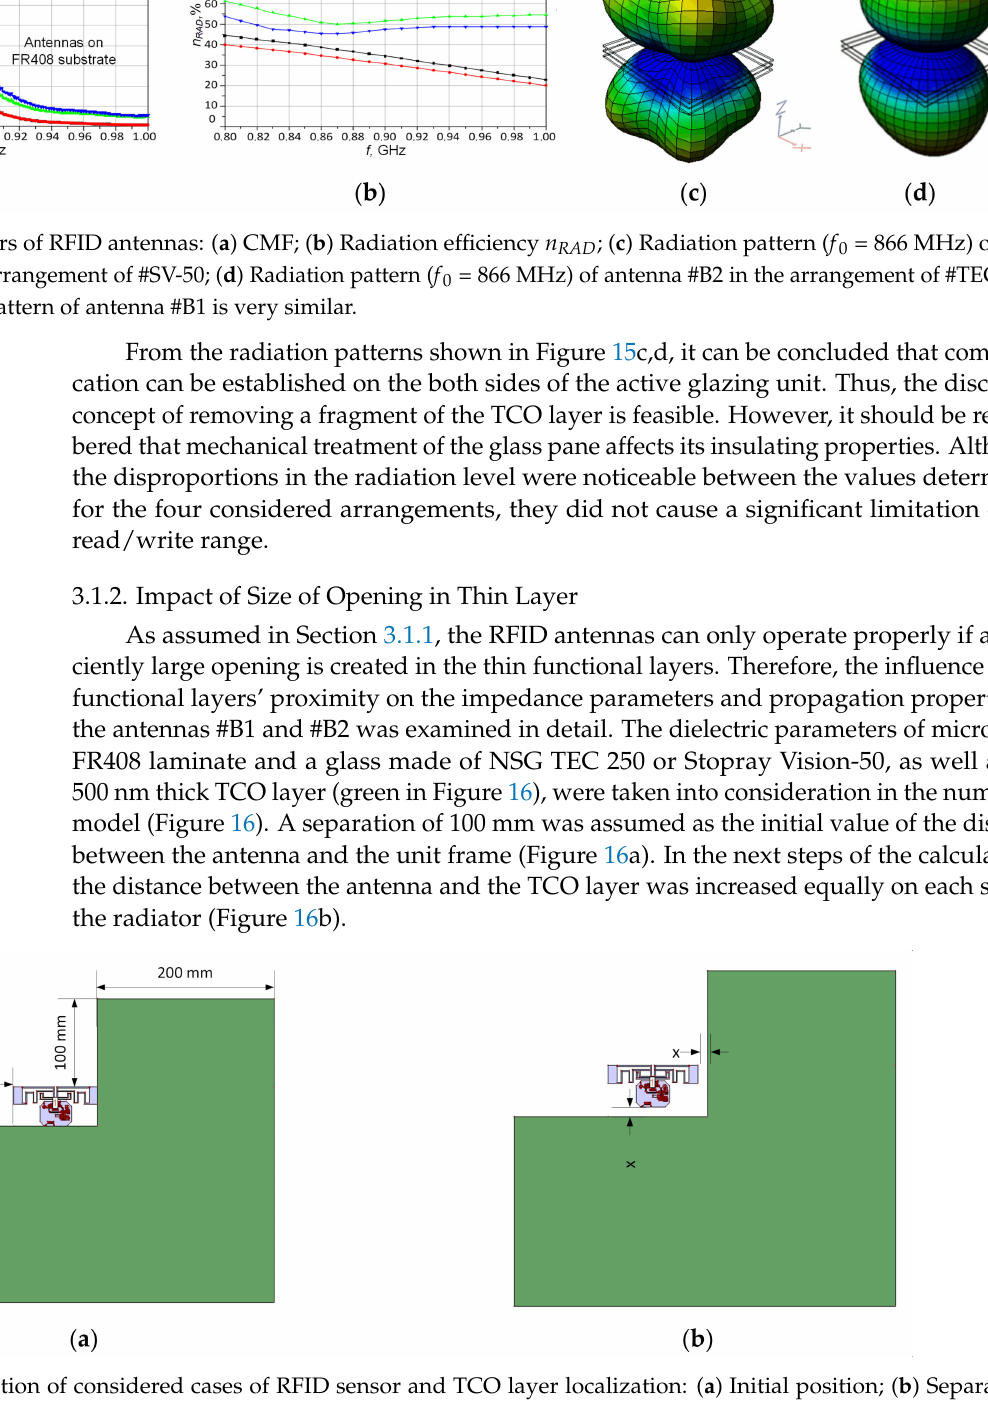
Figure 16. Visualization of considered cases of RFID sensor and TCO layer localization: ( a ) Initial position; ( b ) Separa- tion x = 10 mm, 20 mm, 30 mm, 40 mm, 50